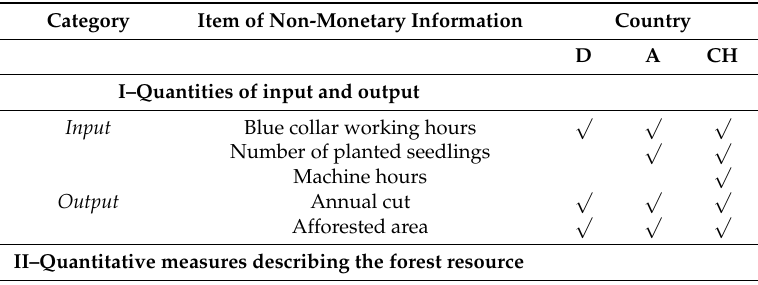
Table 2. Non-monetary information documented in the national German FAN (D), Austrian FAN for larger enterprises (A) and the Swiss FAN (CH) according to the respective guidelines for data collection [45,46] (5 examples for each of the